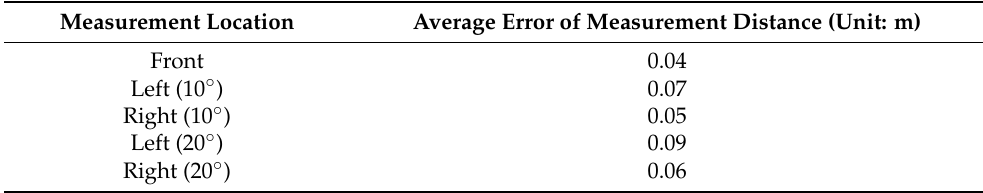
Table 1. Average error between the measurement distance and the actual